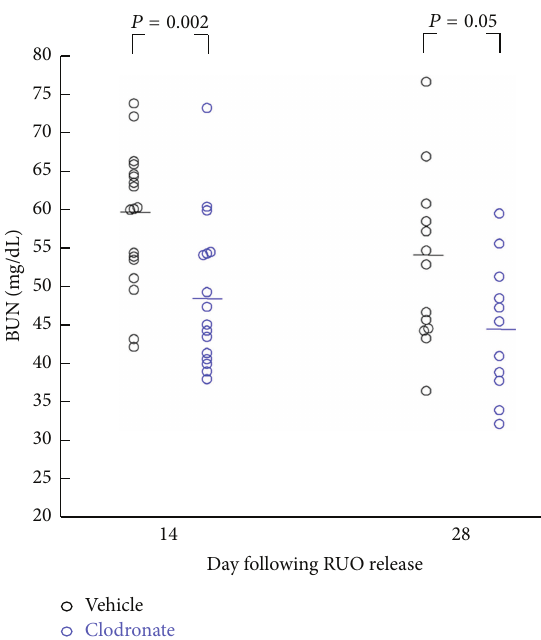
Figure 5: BUN measurements in clodronate-treated and vehicle-treated (control) mice on days 14 and 28 following release of UUO. On day 7, all animals had removal of the contralateral (unobstructed) kidney. 𝑁 = 12 – 19 per group.